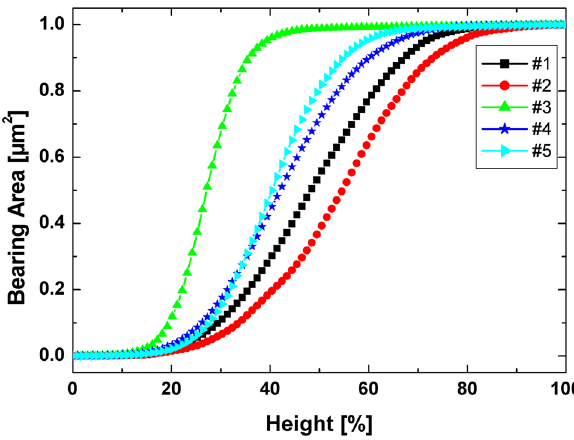
Figure 4. Abbott–Firestone curves of the samples.